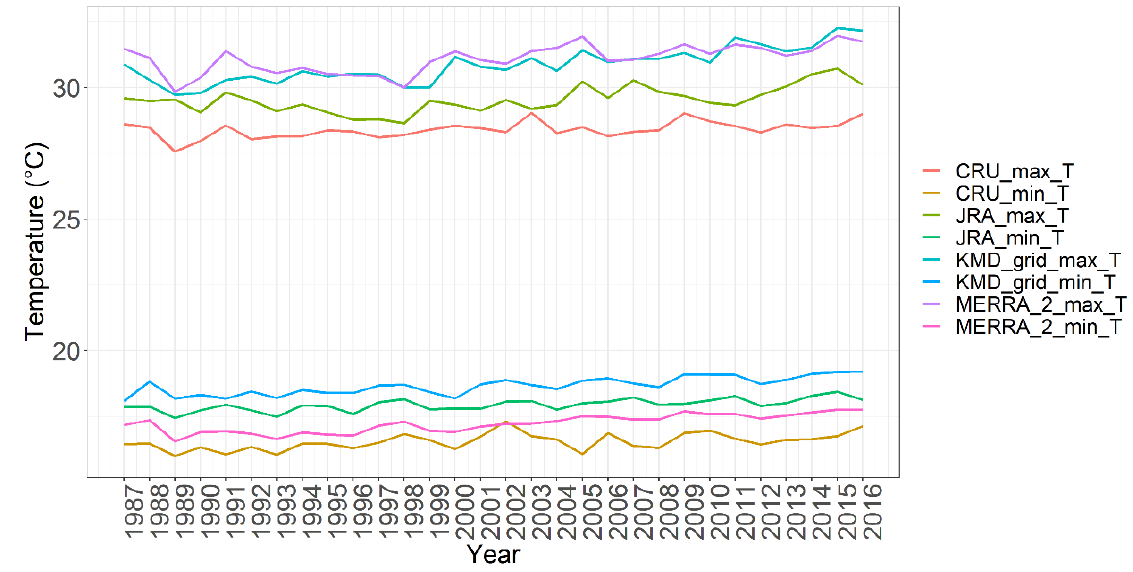
Figure 3. Annual maximum (Tmax) and minimum (Tmin) temperature time series as conveyed by the different data prod- ucts.